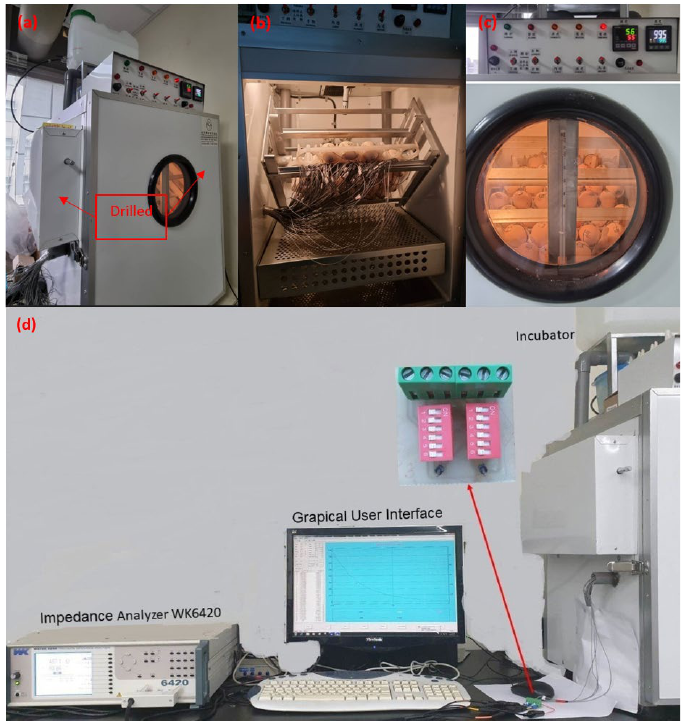
Figure 2. ( a , b ) A small 20 mm diameter hole was drilled into the incubator wall in order to enable the cables to be tunneled out. ( c ) The mac hine settings were set to maintain a consistent